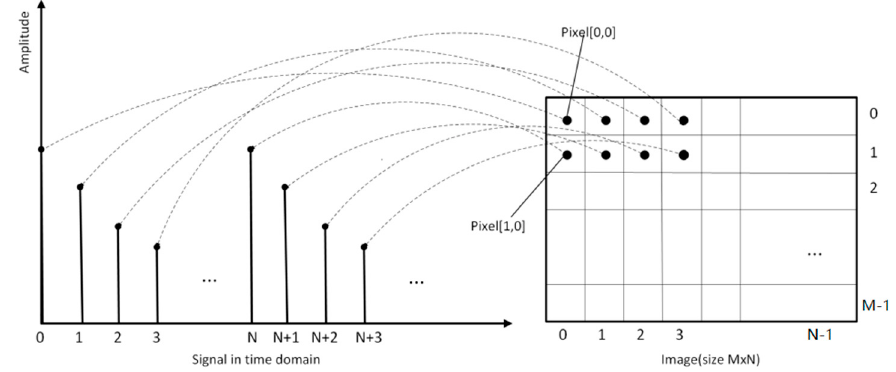
Figure 1. Vibration signal to image translation scheme.